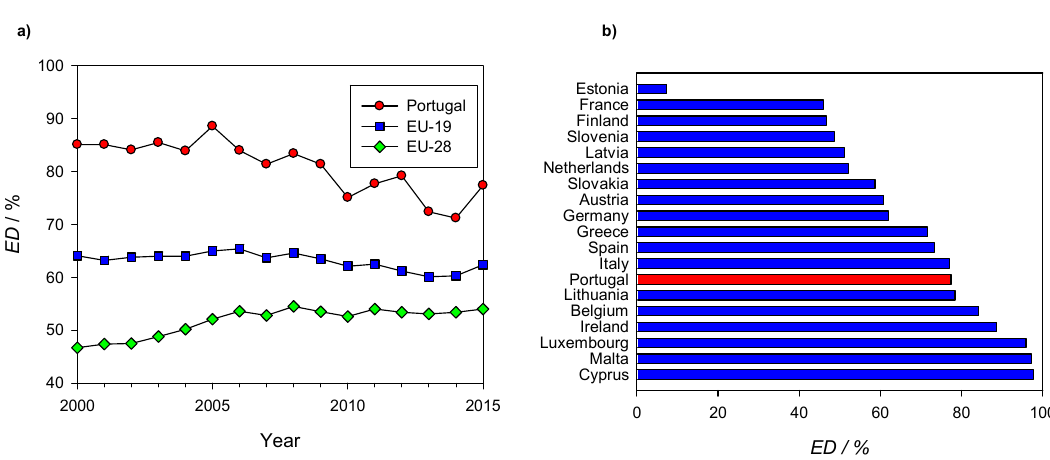
Figure 3. Portuguese energy dependence ( ED ): ( a ) Along recent years and ( b ) comparison with EU-19 countries in 2015. Data taken from Eurostat online database [22]. Portugal had the seventh highest energy dependence among the EU-19 and EU-28 countries in 2015 (cf. Figure 3b). None of the EU-19 countries had a negative energy dependence (cf. Figure 3b), all depending on primary energy imports to satisfy their energetic needs.